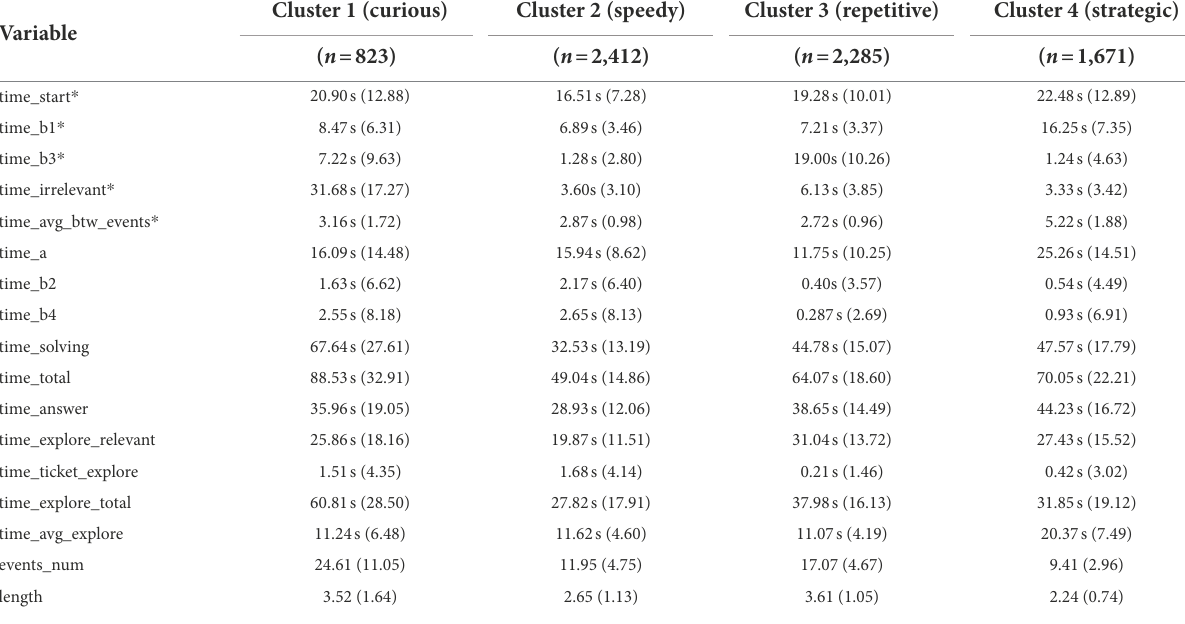
TABLE 4 Descriptive statistics (mean (standard deviation)) of variables by